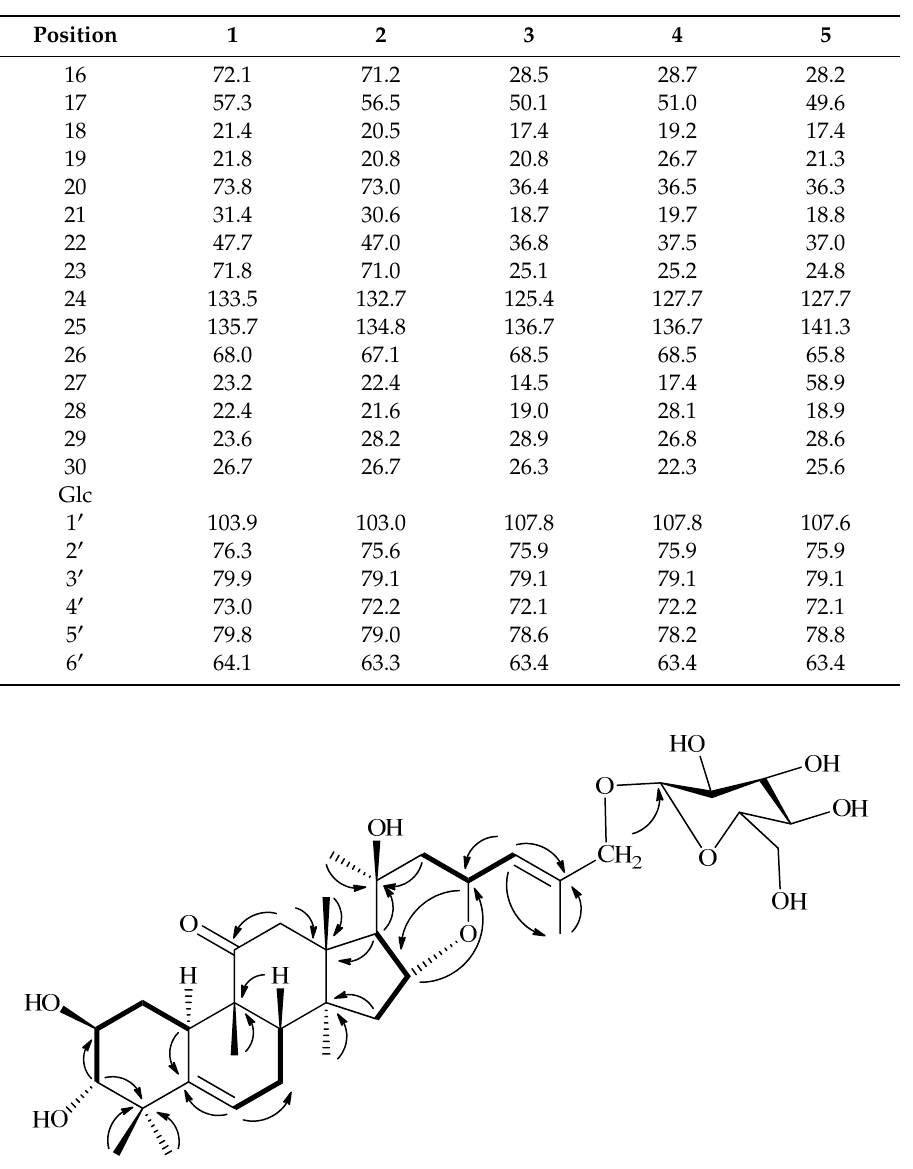
Figure 2. 1 H- 1 H COSY and HMBC correlations of compounds 1 ( 1 H- 1 H COSY; HMBC).